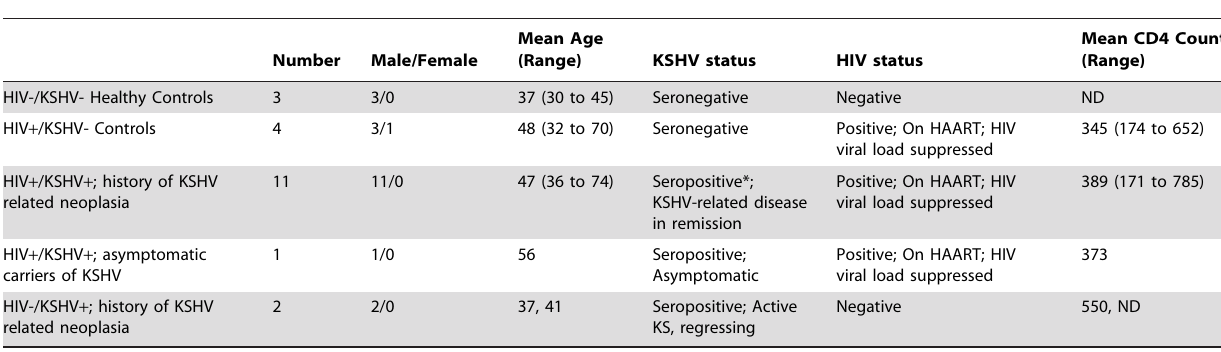
Table 1. Summary of study participant